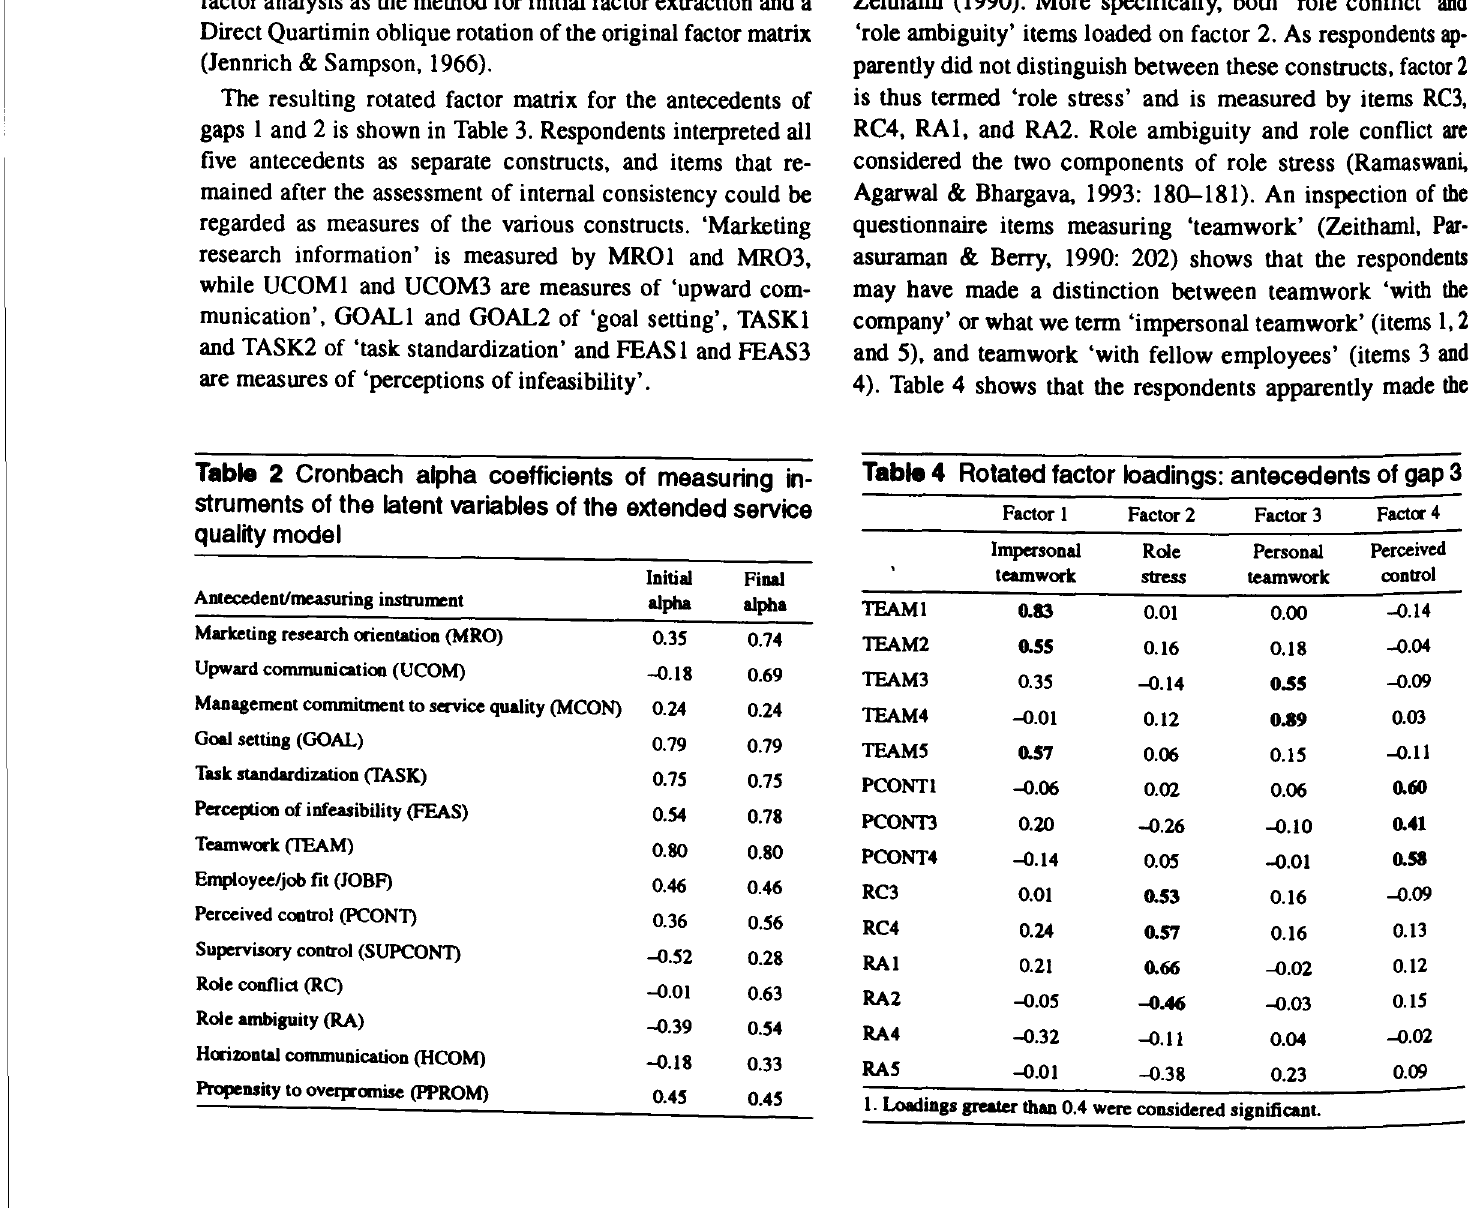
Table 2 Cronbach alpha coefficients of measuring in-